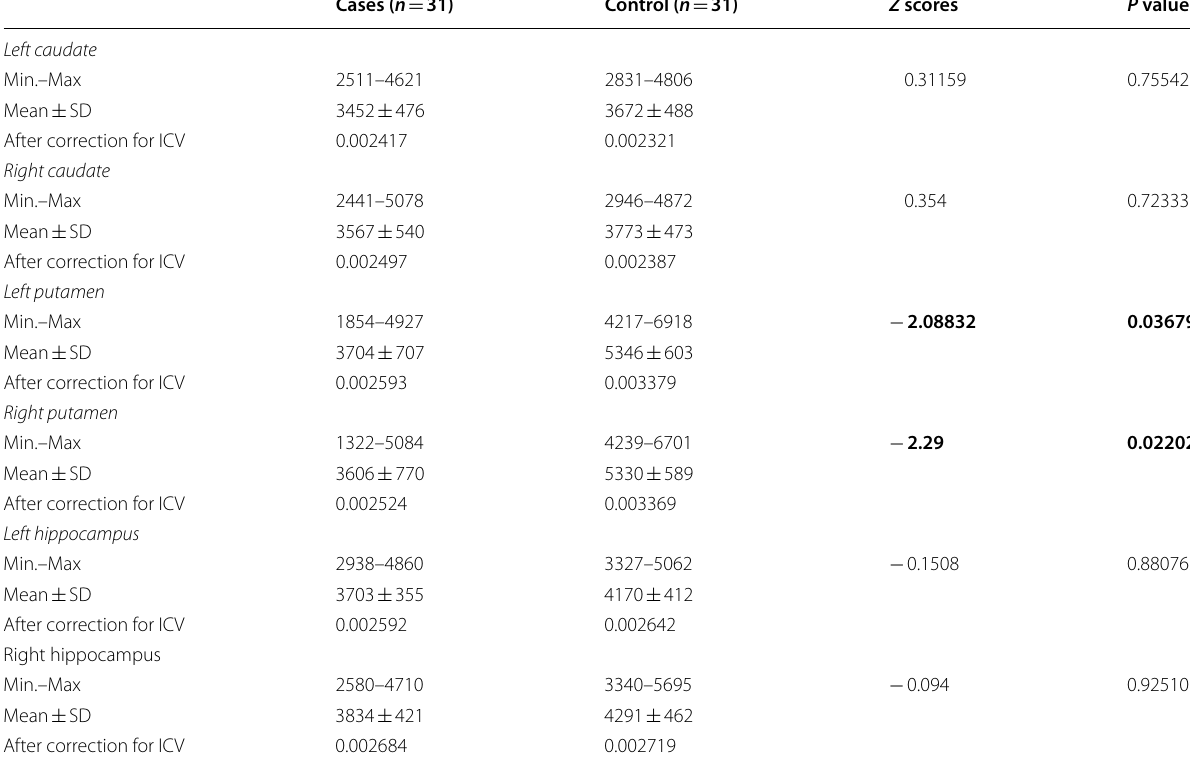
Table 5 Quantitative results of the left and right caudate, putamen, and hippocampi